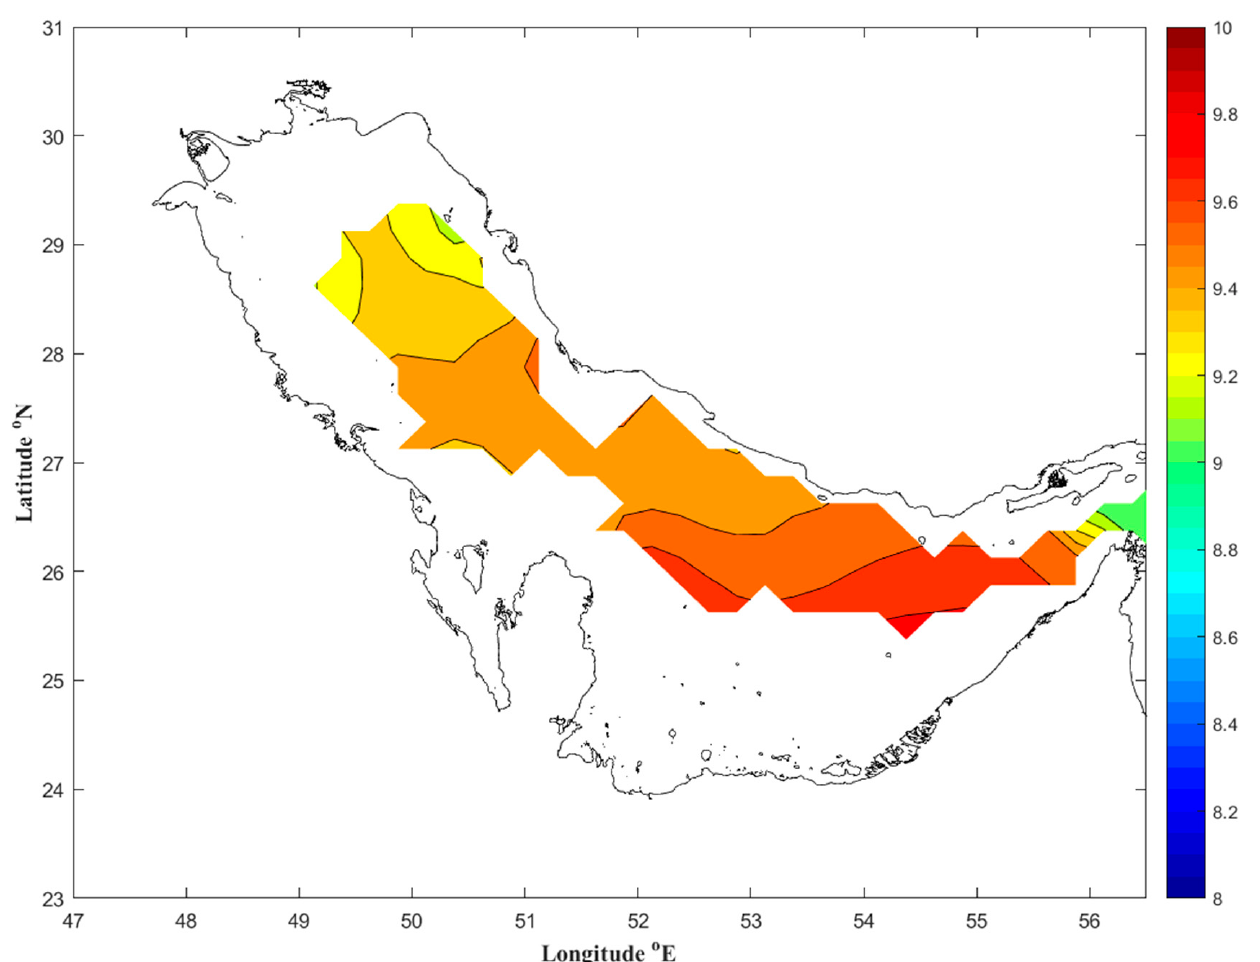
Figure 5. Annual average of heat content (×10 7 Jm − 2 ) in the AG to 35 m.